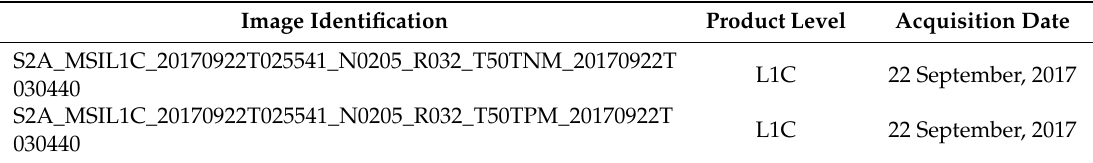
Table 2. Information of the acquired Sentinel-2